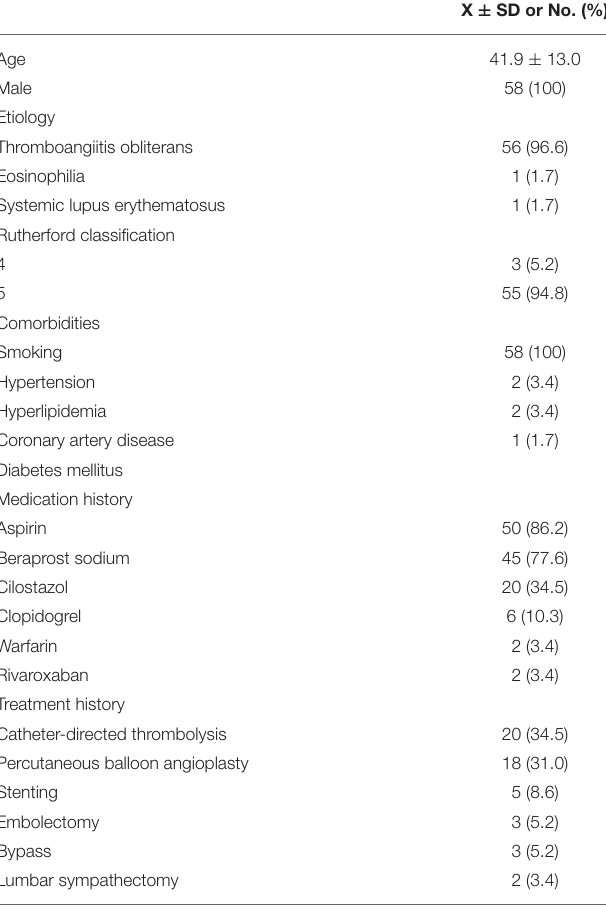
TABLE 1 | Baseline characteristics of